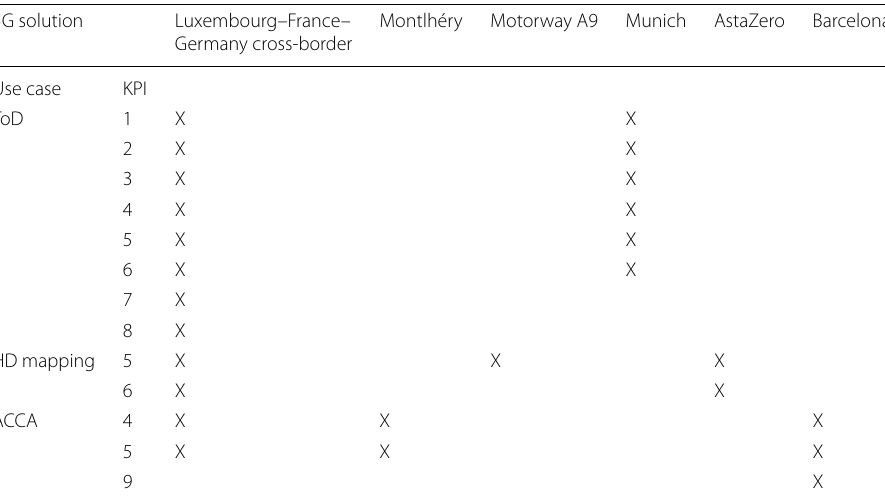
Table 2 KPIs to be evaluated per test and trial site 5G